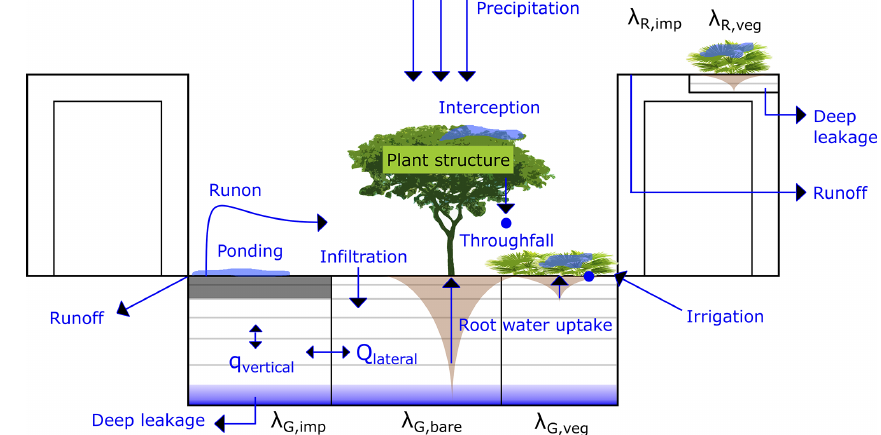
Figure 3. Modelled water fluxes in UT&C. The urban soil is subdivided into three different soil columns according to the impervious ( λ G,imp ), bare ( λ G,bare ), and vegetated ( λ G,veg ) ground fractions. Vertical ( q vertical ) and lateral ( Q lateral ) soil water fluxes are calculated. Runoff occurs when the maximum ponding storage capacity is exceeded. An user-specified fraction of runoff can be kept in the system as